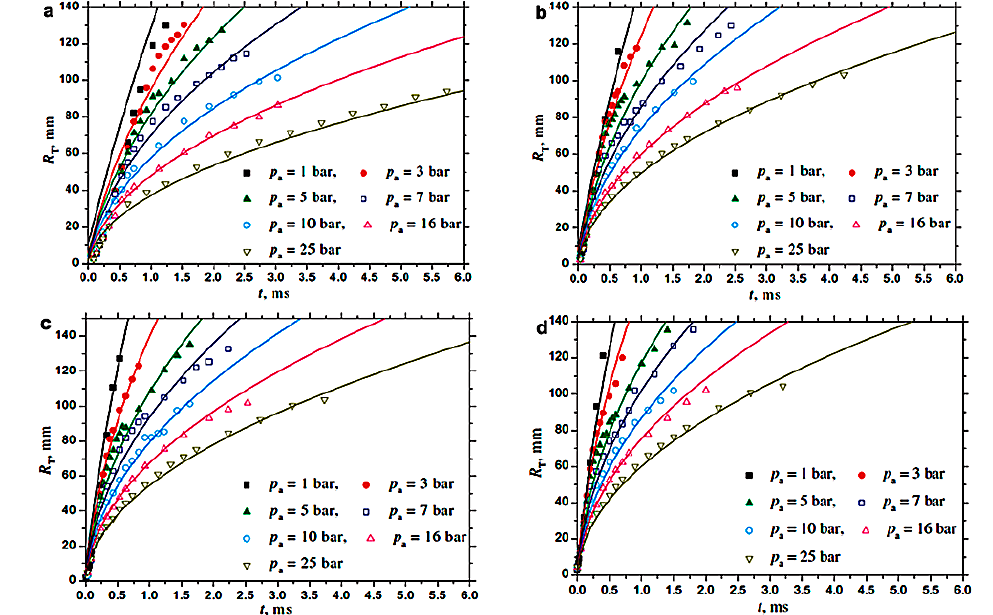
Figure 16. Influence of the ambient pressure on the spray penetration. The injection pressures are: ( a ) P i = 300 bar, ( b ) P i = 700 bar, ( c ) P i = 1000 bar, ( d ) P i = 1350 bar. Dots are their experimentally obtained results. The continuous lines correspond to the proposed theoretical model (Reprinted with permission from Ref. [31]. Copyright 2007, Elsevier Ltd.).